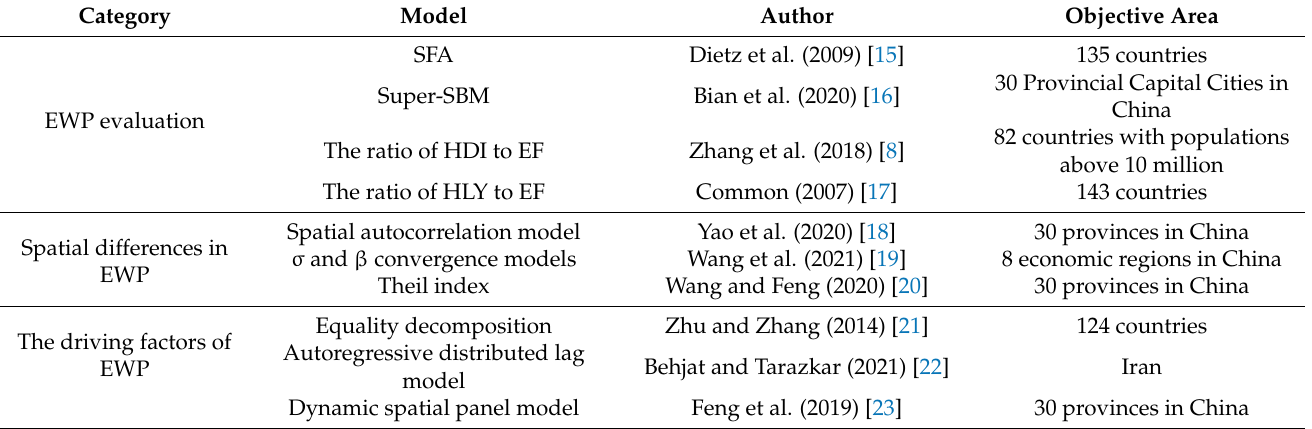
Table 1. Summary of studies related to